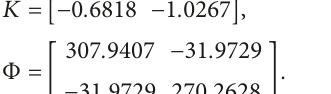
) and f ( x ( s )) under the integral-based ETS k k